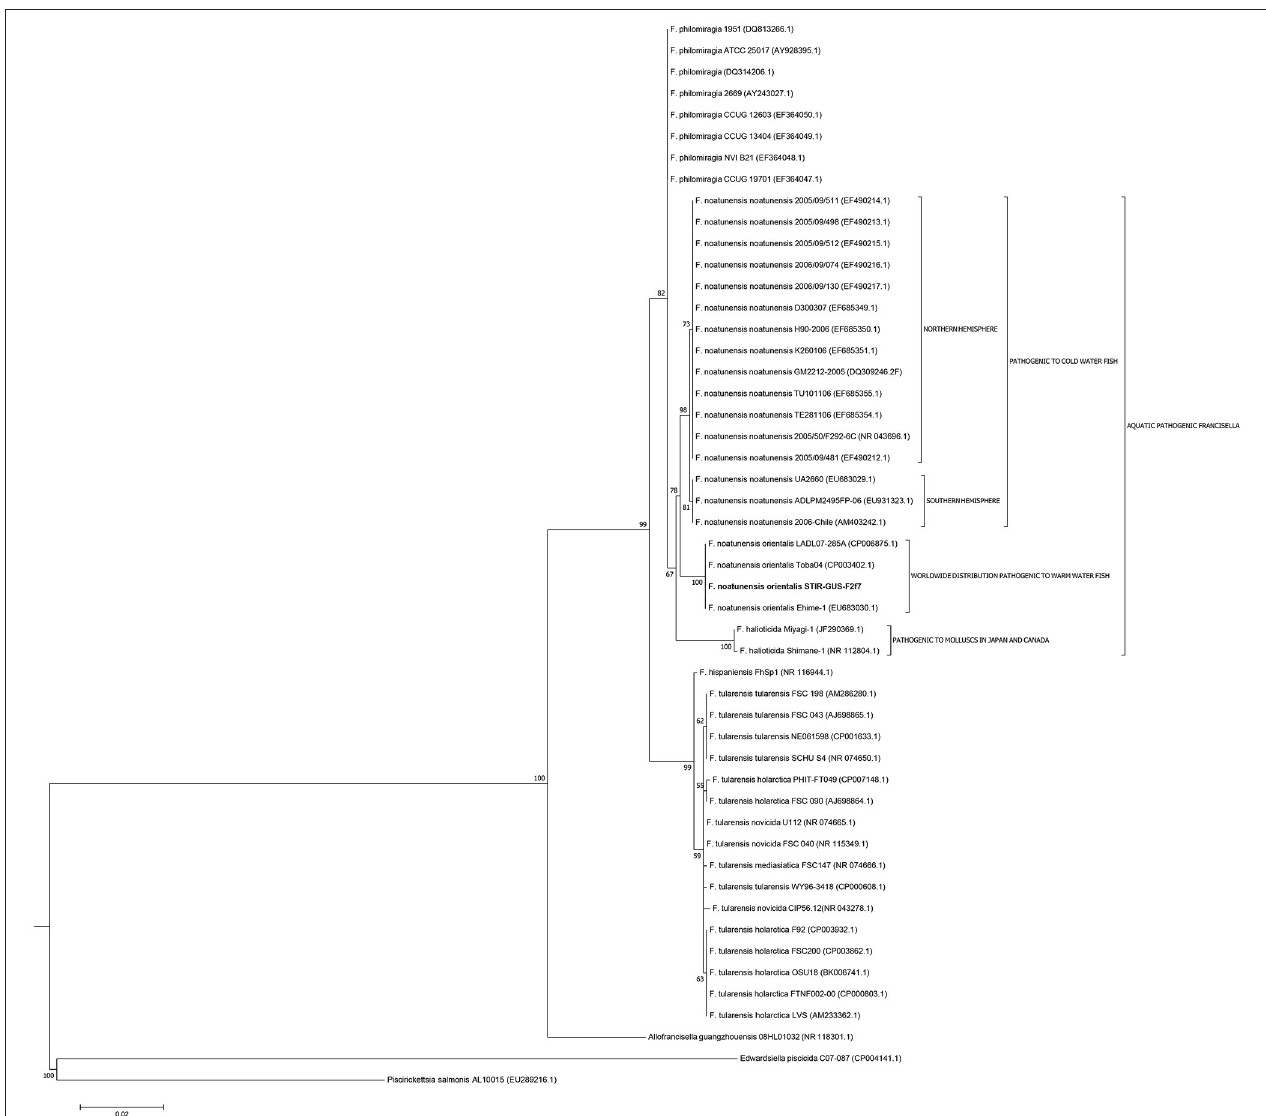
FIGURE 3 | Molecular phylogenetic analysis of the family Francisellaceae based on 50 16S rRNA sequences (1,350 nt). The evolutionary history was inferred using the Maximum Likelihood method based on the Kimura 2-parameter model (Kimura, 1980). The tree with the highest log likelihood ( − 4004.5670) is shown. The percentage of trees in which the associated taxa clustered together is shown next to the branches. Initial trees for the heuristic search were obtained by applying the Neighbor-Joining method to a matrix of pairwise distances estimated using the Maximum Composite Likelihood (MCL)